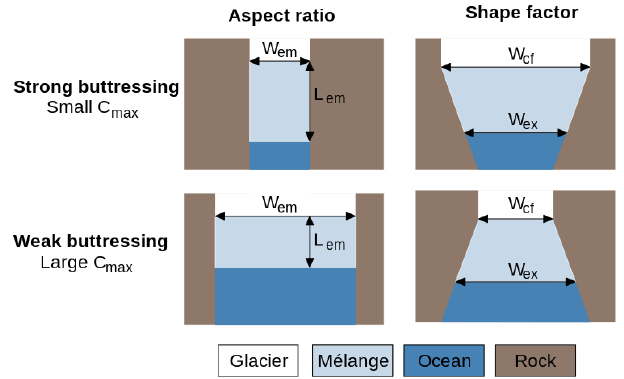
Figure 2. Illustration of how embayment geometry determines but- tressing strength in Eq. (1): aspect ratio L em /W em and shape factor W ex /W cf determine the strength of mélange